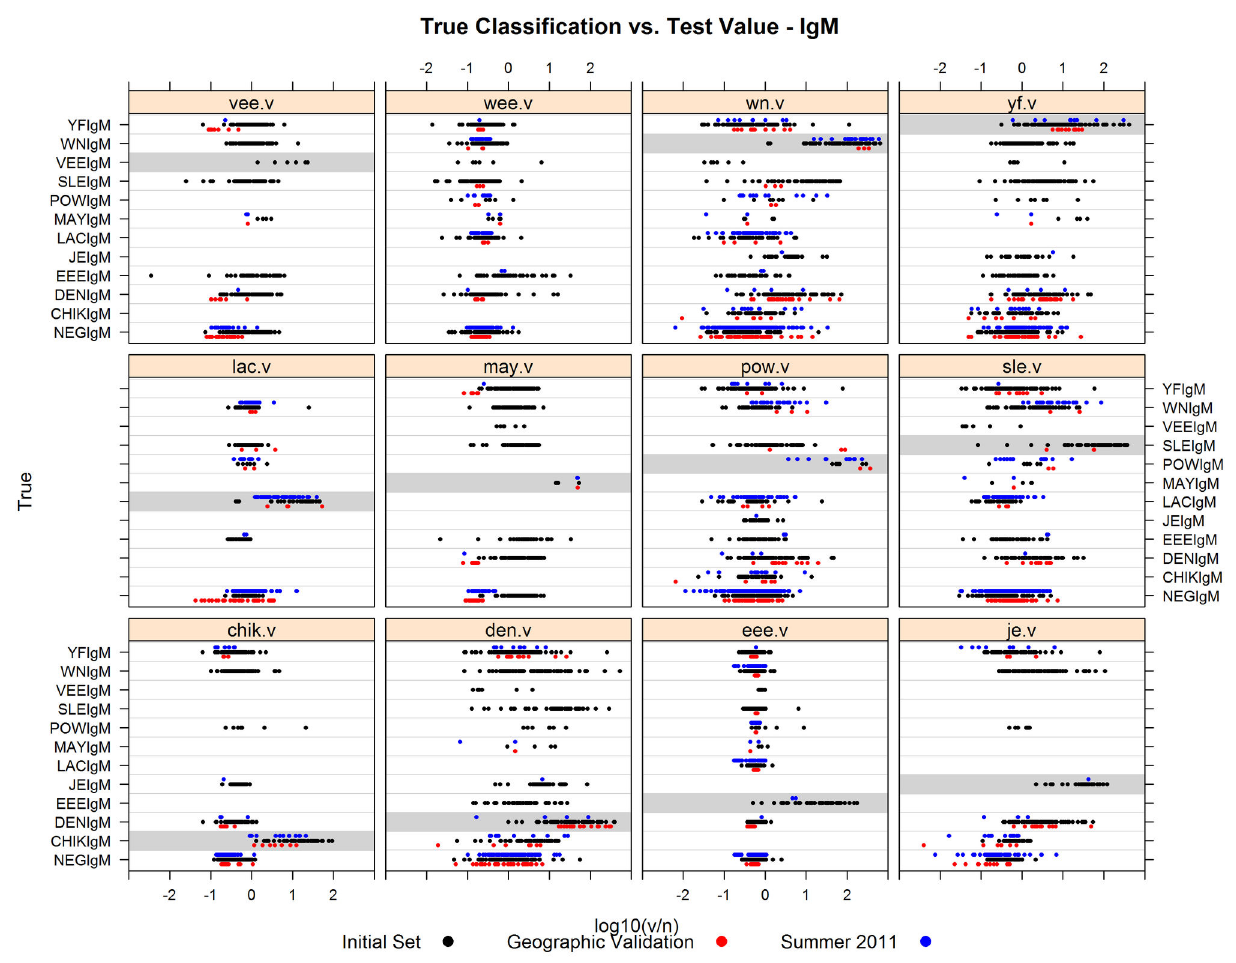
Figure 2. True classification vs. test value – IgM based on V/N. True classification (y-axis) refers to the original diagnostic result based on the traditional screening method plus plaque reduction neutralization, and test value (x-axis) is the V/N measurement for each sample. Samples in each set used in the analyses are depicted: black dots represent the initial set; red dots represent the geographic validation set; blue dots represent the summer 2011 set. Sample rows for the infecting virus are shaded grey in each antigen